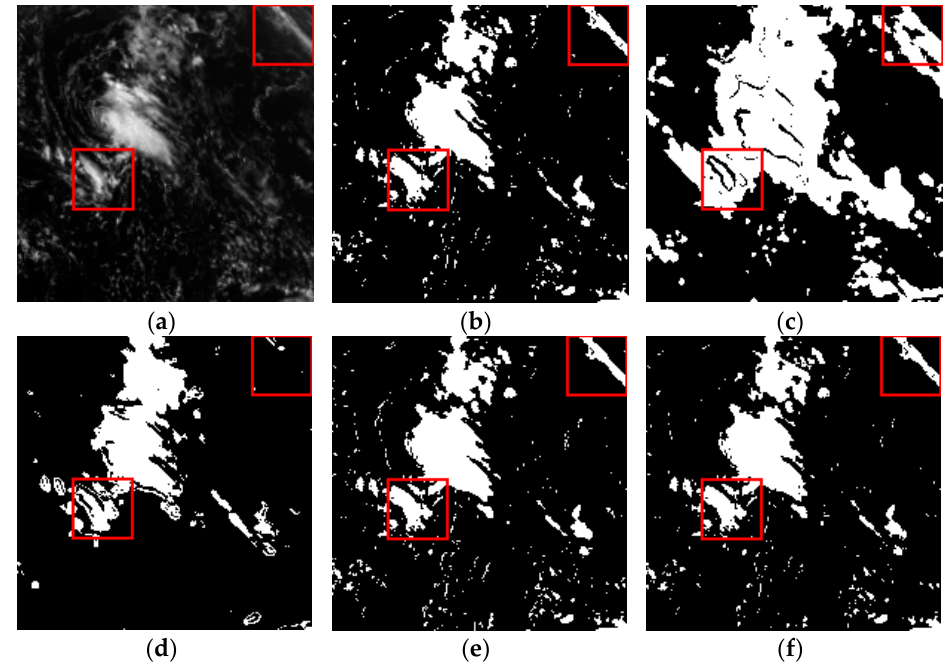
Figure 14. The enlarged subset of results. ( a ) Visible image; ( b ) Ground truth; ( c ) NSMC result; ( d ) NSMC-RF result; ( e ) Ensemble threshold-RF result; ( f ) Proposed RF result.